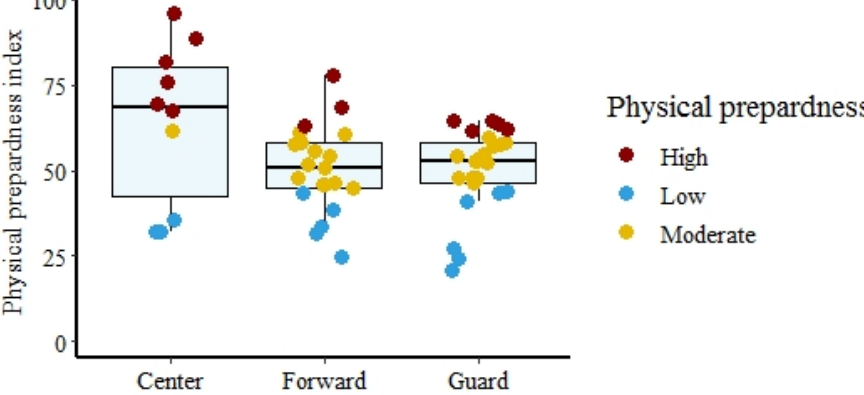
Figure 3. Positioning of players according to playing position from the aspect of specific prepara- tion level.